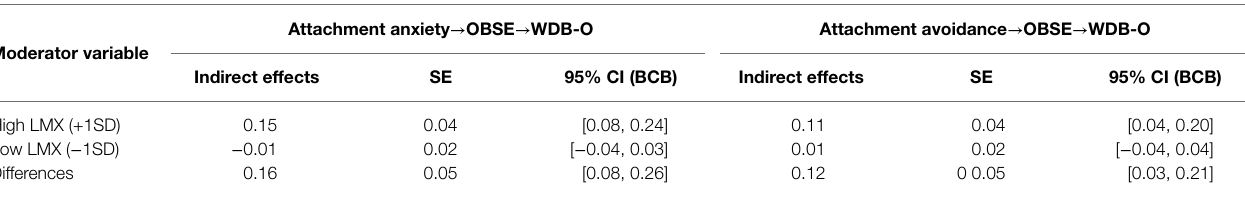
TABLE 3 | Results of the moderated mediation